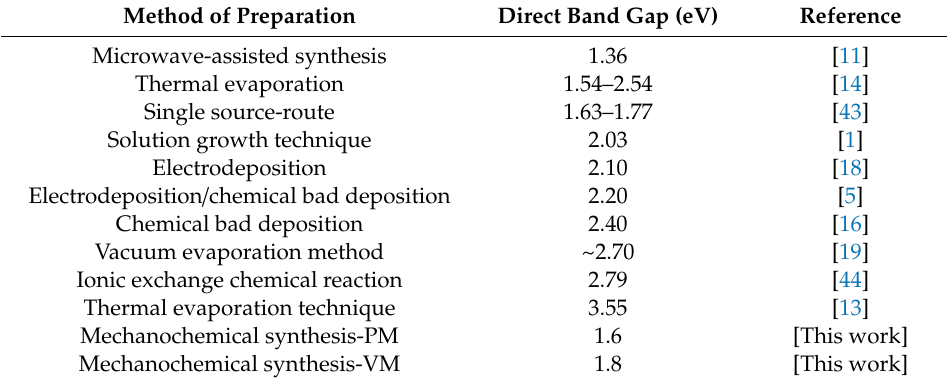
Table 3. The published values of CuSe direct band gaps prepared by various methods.